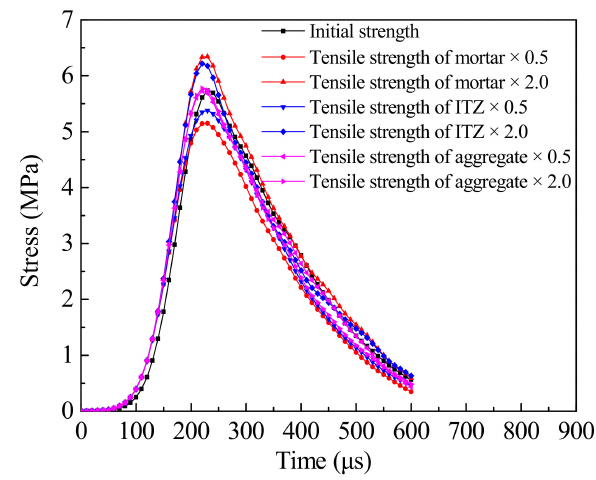
Figure 11. Tensile stress history curves under different